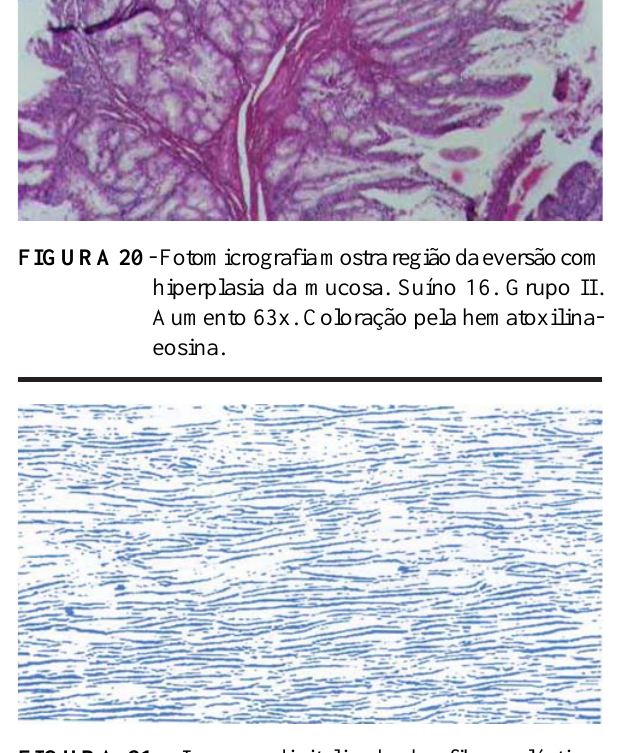
FIGURA 21 - Imagem digitalizada das fibras elásticas captadas da lâmina corada pelo método fúcsina-resorcina de